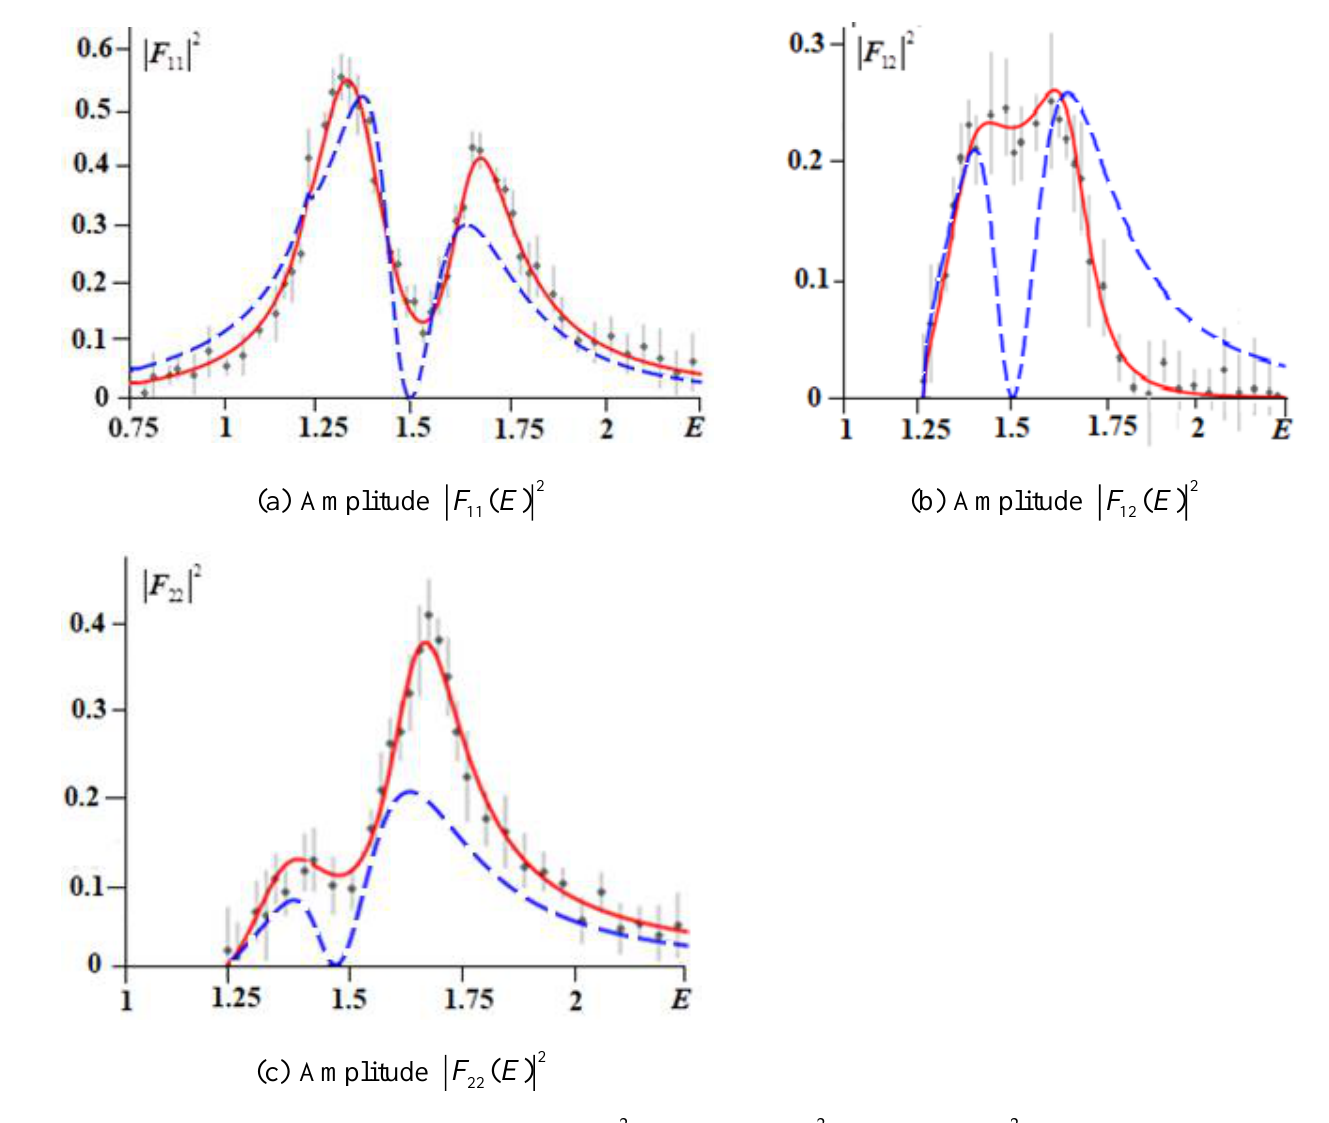
Figure 2. Panel ( a ) | F 11 ( E ) | 2 , panel ( b ) | F 12 ( E ) | 2 , panel ( c ) | F 22 ( E ) | 2 . Red solid lines—BW formula Figure 2. Panel (a) . Red solid lines — BW (44); blue dashed lines— K -matrix Equation (46); threshold E 2 = formula (44); blue dashed lines — К -matrix Equation (46); threshold